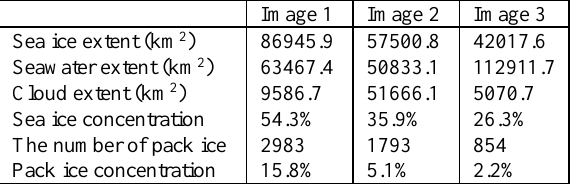
In Figs. 5, black arrows indicate the pack ice motion vectors derived from FY-3/MERSI images. The starting point of the arrow is the mass centre of the tracked pack ice, with longer arrows representing quicker motion velocity. Red arrows indicate the polar daily grid sea ice motion vectors provided by